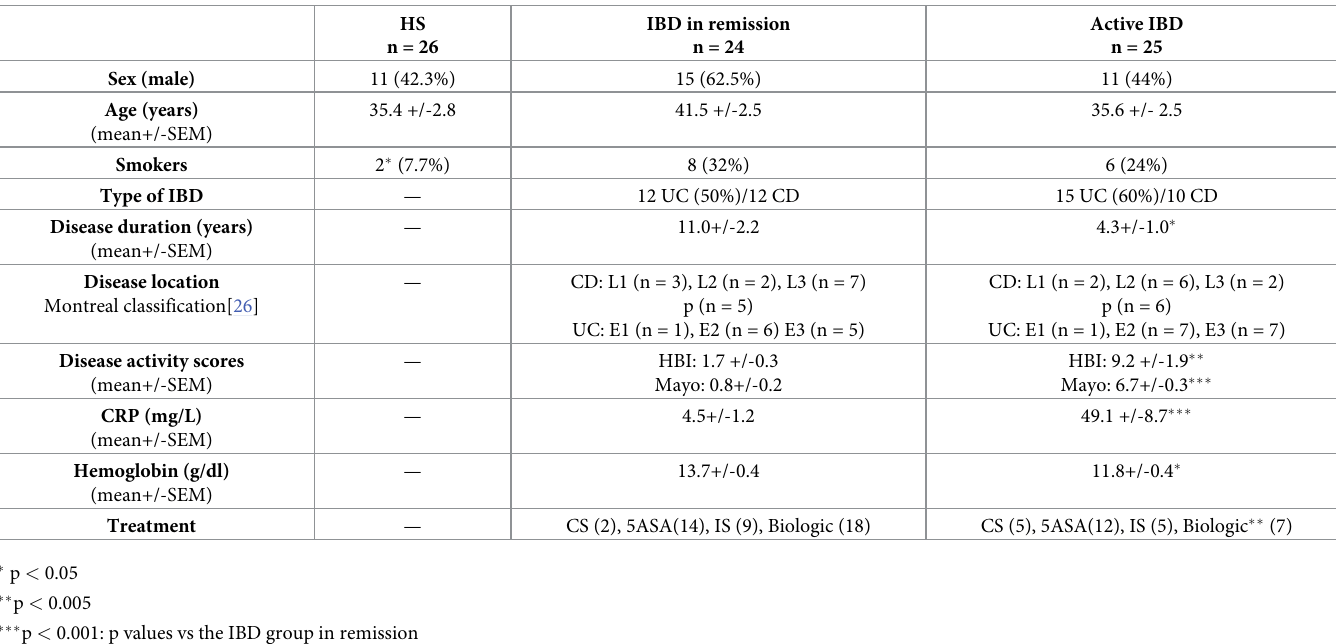
Table 1. Patients and controls